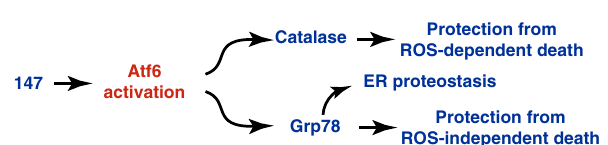
Fig. 9 147 mediates both ROS-dependent and ROS-independent protection globally. Proposed mechanism whereby 147 confers widespread global protection within the cell through activation of ATF6 to act both in a canonical and non-canonical manner to protect against ROS-dependent